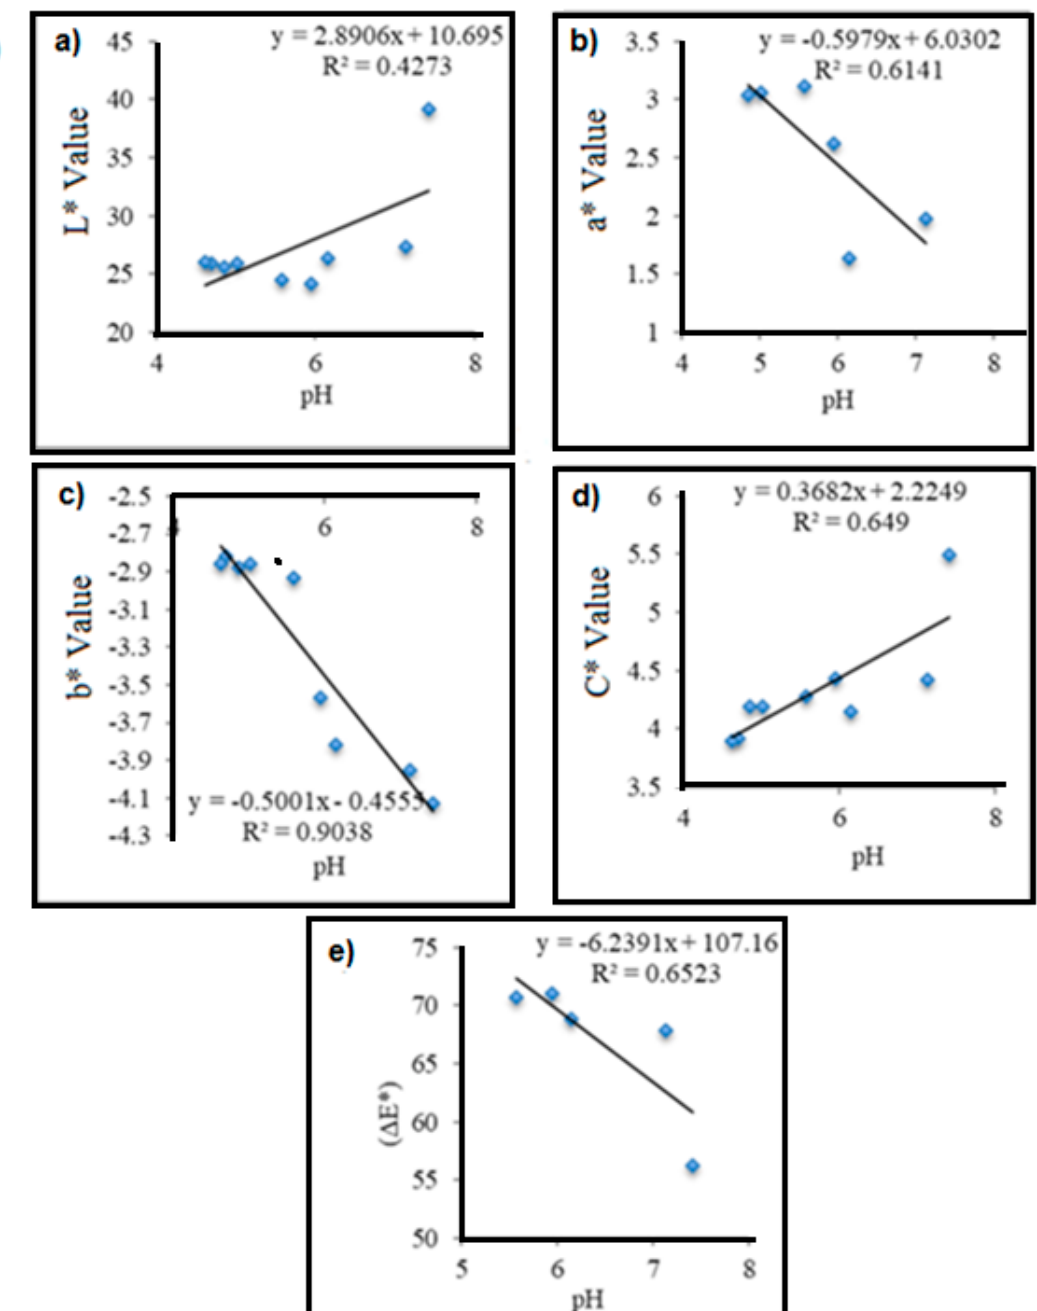
Figure 5. Sample of ( A ) shrimp samples ( B ) durian sample based on correlation studies between color parameter of colorimetric pH sensor film and pH values.